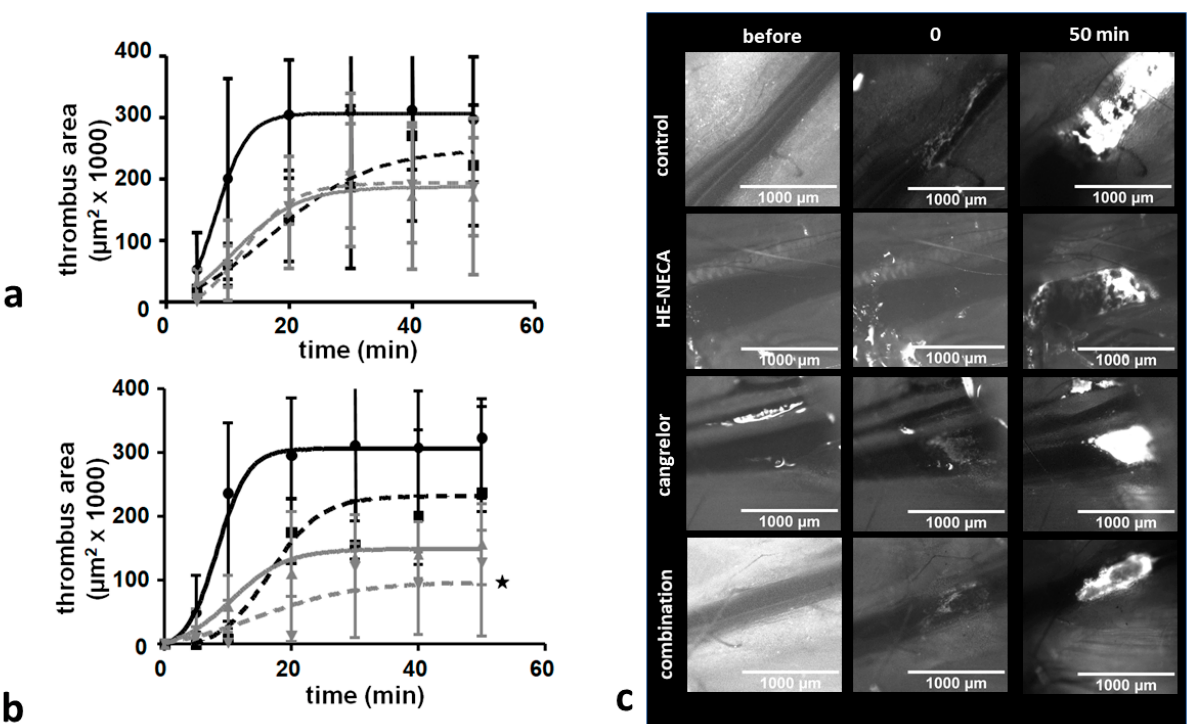
Figure 2. Effects of cangrelor and HE-NECA applied alone and in a combination on the size of thrombus induced with the use of FeCl 3 in the jugular vein in mice. ( a ) Circles—DMSO, squares—HE-NECA 2 mg/kg b.w., triangles—cangrelor 0.1 mg/kg b.w., inverted triangles—cangrelor + HE-NECA. ( b ) Circles—DMSO, squares—HE-NECA 4 mg/kg b.w., triangles—cangrelor 0.2 mg/kg b.w., inverted triangles—cangrelor + HE-NECA. Data are shown as median with IQR, n = 5–7. Curves were fitted with the four-parametric equation with a shared bottom value, using transformed data. Kruskal–Wallis test followed by Dunn’s multiple comparison test were used to compare thrombi area 50 min. after initialization of thrombus formation. * p < 0.05 (corrected for multiple comparisons). Panel ( c ) shows exemplary images of thrombi formed in mice treated with DMSO or with a combination of HE-NECA 4 mg/kg b.w. and cangrelor 0.2 mg/kg b.w.